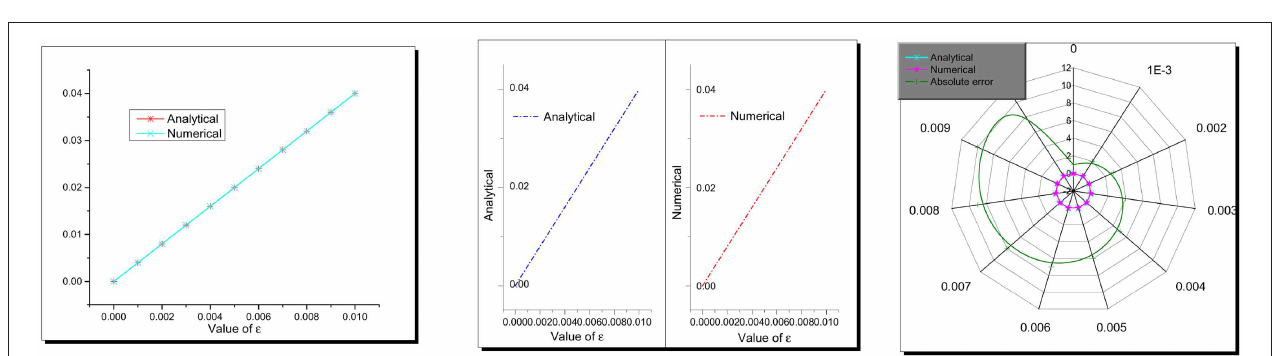
FIGURE 1 | Three, two-dimensional, and contour plots of Equation (12), respectively.